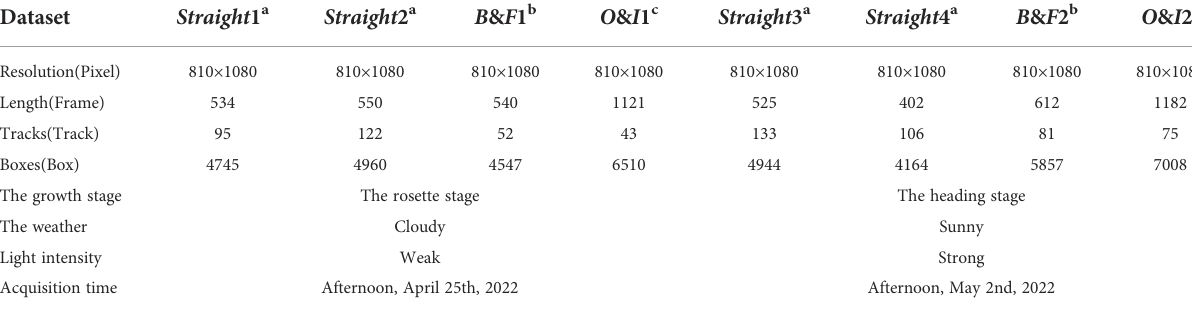
TABLE 2 Summary of eight parts of the dataset.